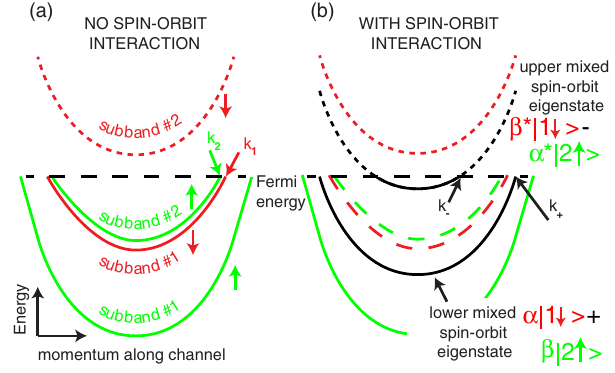
FIG. 2. The effect of SO coupling illustrated for two subbands (1 and 2) with different lateral orbital wave functions. (a) Without SO the in-plane magnetic field splits each subband into spin-up and spin-down subbands separated by the Zeeman energy E . At the resonance condition, Z Eq. (21), the spin-down states of subband 1 coincide with the spin-up states of subband 2. (b) With SO these states mix, and the SO-coupling-induced mixing is strongest exactly at ffiffiffi p 2 the resonance condition, where j α j ¼ j β j ¼ 1 =